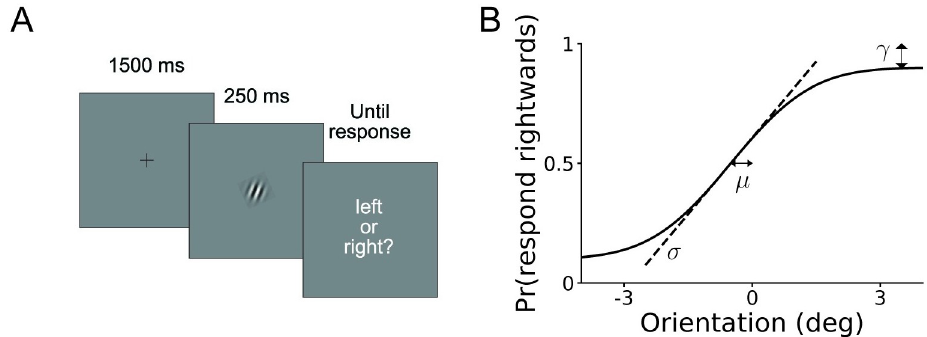
Fig 4. Orientation discrimination task. A . Trial structure of the simulated task. A oriented patch appears on a screen for 250 ms, after which participants decide whether it is rotated rightwards or leftwards with respect to a vertical reference. B . Graphical illustration of the behavioral model, which specifies the probability of choosing rightwards as a function of the true stimulus orientation. The three model parameters σ , μ , and γ correspond to the (inverse) slope, horizontal offset and (double) asymptote of the psychometric curve, as per Eq 20. Note that we parametrize the model with η � log σ .